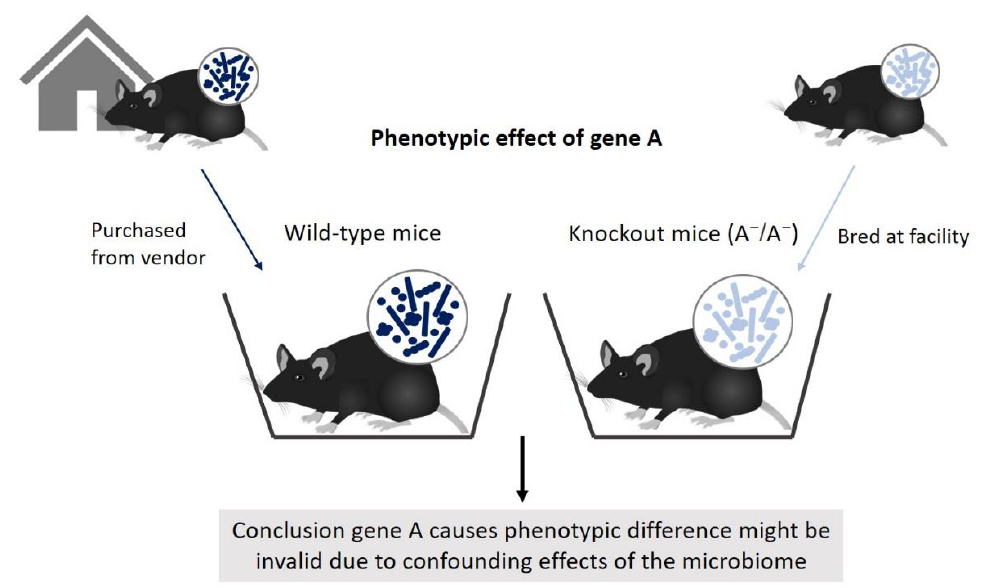
Figure 2. Comparisons between wild-type and knockout mice are at risk of bias due to differences in microbiome composition resulting from separate breeding.